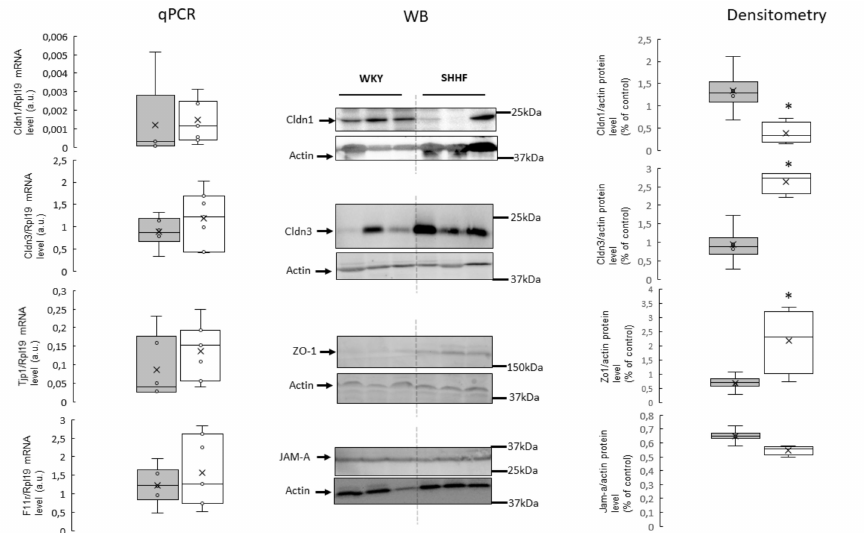
Figure 4. RT-qPCR analysis of claudin 1 (Cldn1), claudin 3 (Cldn3), zonula occludens-1 (ZO-1), and F11r transcript levels in the jejunum of the WKY and SHHF rats. (displays on histogram in arbitrary units (means ± SD, n = 6–7). Western blot analysis of Cldn1, Cldn3, ZO-1 and junctional adhesion molecule A (JAM-A) protein levels from total protein extract prepared from the jejunum. A representative immunoblot is shown. Immunolabeled Cldn1, Cldn3, ZO-1, JAM-A and beta actin loading control bands were quantified using a Molecular Imager. The relative levels of the test proteins are plotted in arbitrary unit (means ± SD), grey bars—Wistar Kyoto rats, white bars—spontaneously hypertensive heart failure rats, * p < 0.05 by t